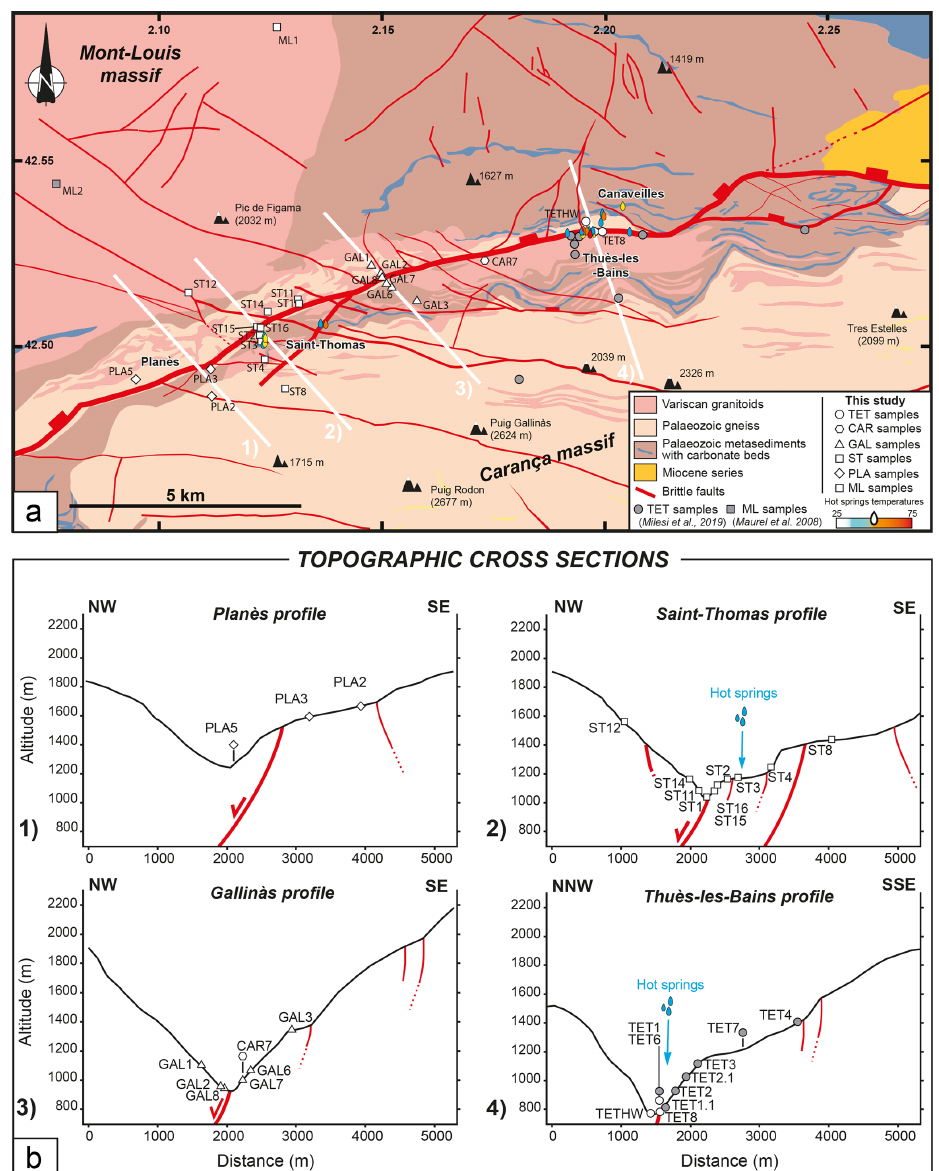
Figure 5. (a) Structural map modified from Taillefer et al. (2017) showing the four sampling profiles. Grey shows samples from previous studies (Maurel et al., 2008; Milesi et al., 2019); in white are new samples from this study. (b) Topographic cross sections of the four transects with the projection of the dated samples (vertical scale exaggerated 2 times). (1) Planès, (2) St Thomas, (3) Gallinàs, and (4) Thuès-les-Bains. White samples are new samples from this study, and grey samples from Thuès-les-Bains are from Milesi et al. (2019). Projected samples are above topographic